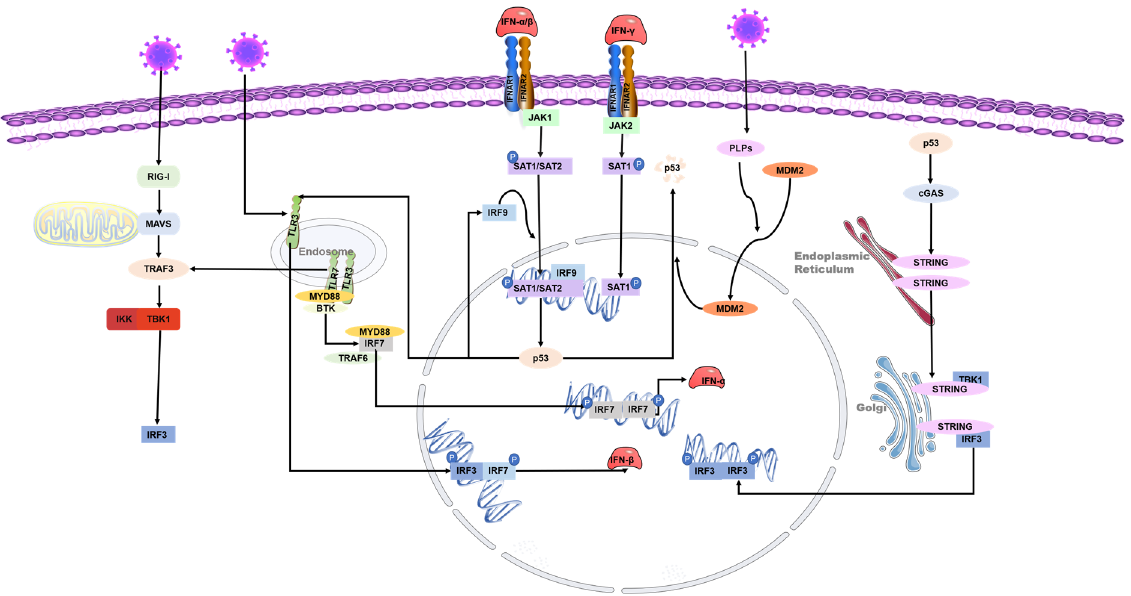
Figure 3. Role of p53 in the regulation of interferon during coronavirus infection. The toll-like receptor and RNA helicase retinoic acid-inducing gene I (RIG-I) are activated after the RNA virus invasion of cells. IRF3 is phosphorylated to produce type I interferon. The JAK-STAT signaling pathway is subsequently activated, and the transcription factors STAT-1, STAT-2, and IFN regulatory factor 9 (IRF9) bind to induce p53 expression. IRF9 is also a p53 target gene and is regulated by p53. Virus infection activates p53-mediated TLR3, phosphorylates downstream IRF3 and IRF7 to form dimers, and promotes the synthesis of type I interferon. p53 also activates IRF3 through the p53-cgas-STING pathway. In addition, coronaviruses can evade the host’s natural immune defenses by degrading p53 through their papain-like proteases (PLPs).